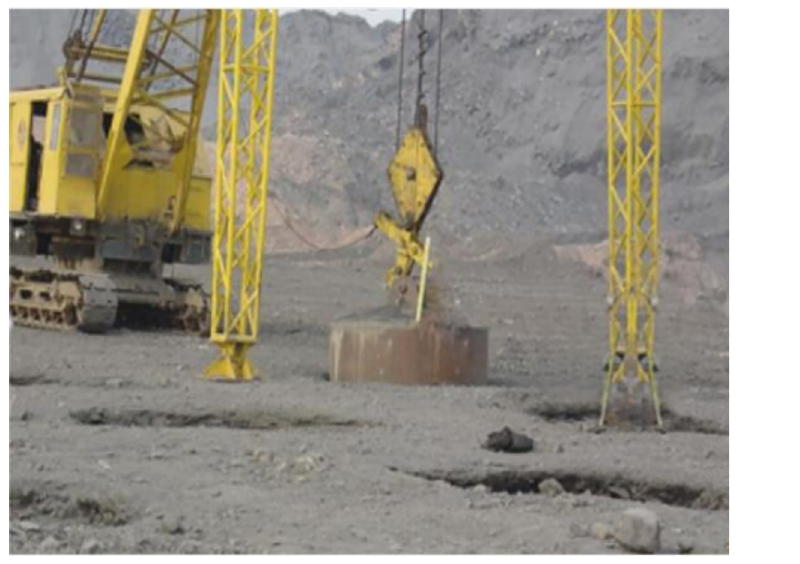
Fig 4. DC field test.